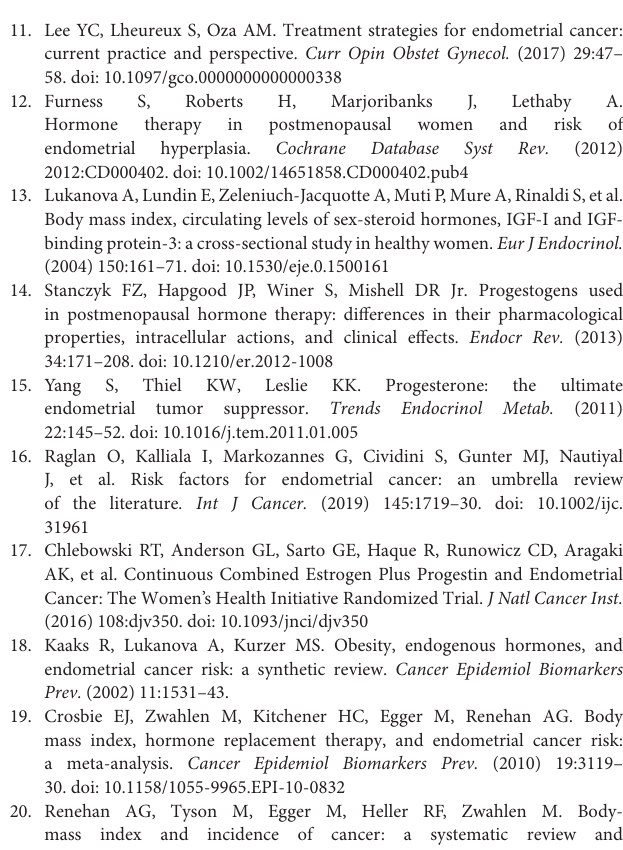
Supplementary Figure S1 | Study flowchart for identifying eligible individuals. PLCO, the Prostate, Lung, Colorectal and Ovarian Cancer Screening Trial; SQX, supplemental